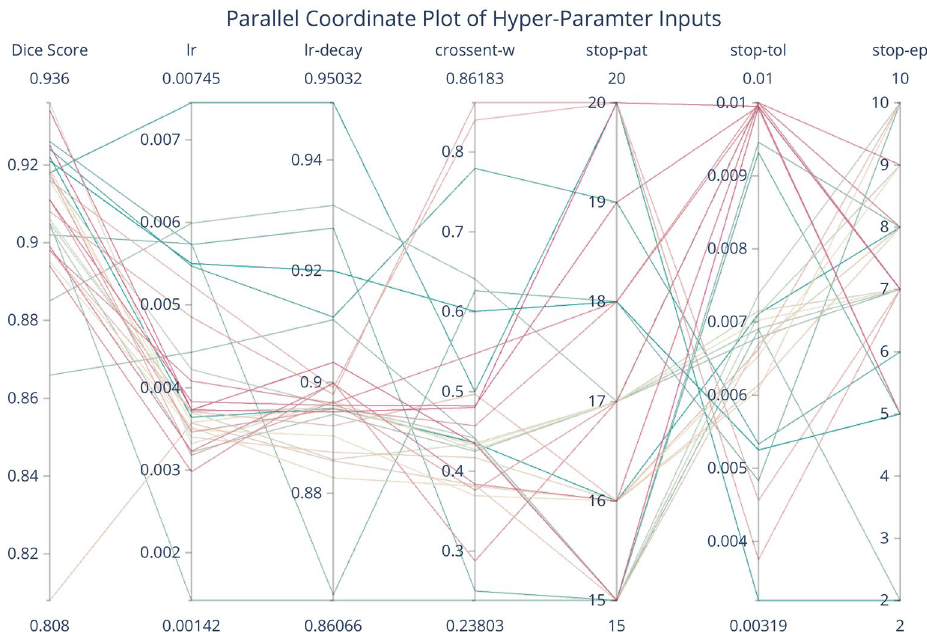
Figure 7. Parallel Coordinate plot describing the relationship between the hyper-parameters and the resulting Dice score for all 30 trials. We can see from this plot that the model prefers a smaller learning rate as well as a larger stopping tolerance. Other parameters seem to have a smaller effect on the overall